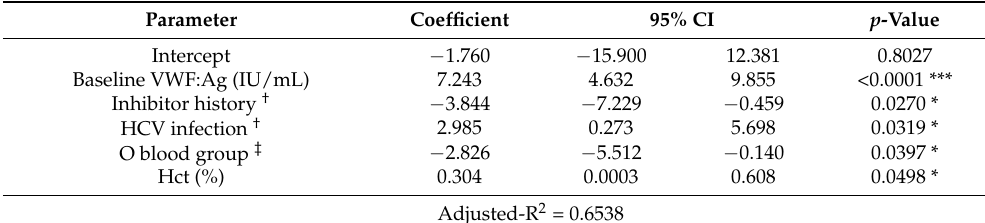
Table 8. Stepwise-backwards MVLR analysis of the half lives of the entire development cohort of patients, n =